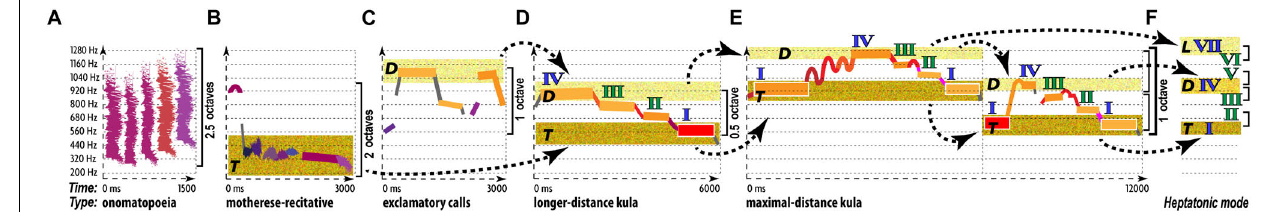
FIGURE 8 | Genesis of SFTO in the vocal tradition of kulning. The set of six panels shows five excerpts representing five different vocalization types from Figure 7 . They are placed on the same frequency grid to demonstrate how the registral position of phrasal tones evolves into a frequency range used to define a degree in a musical mode. Thin dashed vertical line indicates the phrasal ends. Thick curved dashed arrows show the genesis of “tonic” (principal stable) and “dominant” (principal unstable) degrees, eventually shaping a heptatonic mode. (A) Mid-distance onomatopoeia (barking) . This is the closest to ACs. A phrase repeats the same wideband aperiodic signal whose most intense part of the spectrum spreads over ≈ 2.5 octaves. (B) Close distance motherese/recitative . Low-register tones in such phrases tend to fall within the same narrow range of 250–290 Hz (257 c), marked by the darker grainy filling. Frequently repeated voiced vowels effectively refine the tuning of the “recitative tone” that adopts a tonic function (“T”) established by the common terminations of phrases. (C) Mid-distance exclamatory calls . High-register “shrieking” tones in such phrases are squeezed in a twice narrower range, marked by a lighter filling. These shrieking tones complement low tones in (B) in providing reference for pitch changes. Such tones prototype the “dominant” melodic function (“D”). Tones that fall in this register become imperfect “anchors” subdued to “tonic”—requiring a descending melodic “resolution” after them. (D) Longer-distance kula . Registral ranges of both “tonic” and “dominant” are further compressed into “degrees” of a simple 4-degree musical mode. Colored Roman numerals use blue for anchored tones, and green—for supporting tones (passing or auxiliary). Tonic function (stability) is shaped by the lowest degree terminating a phrase, whereas dominant function (instability)—by the highest degree initiating a phrase. This transformation is fueled by frequent stitching of (B) , (C) , and (D) phrases within the same musicking session as the distance changes. (E) Longest-distance kula . This type doubles the TO structure of the shorter distance kula—indicated by two thin vertical brackets encapsulated by one thick bracket. A similar tetrachordal structure is reproduced above the base-tetrachord. Both tetrachords are conjoined: the lowest stable degree (“T”) of an upper tetrachord becomes the highest unstable degree (“D”) of the lower tetrachord as kula descends from its opening phrase toward lower phrases, terminated by the lowest permanent “tonic.” Repeated use of such complex structure (common at distances over 1 km) is likely to turn it into a modal framework for the entire kulning, encompassing all its phrasal types. (F) Heptatonic mode in complex kulas . Frequent modulations between the conjoined tetrachords integrate both tetrachords into a single complex 2-tetrachordal mode with three axial degrees: the lowest I —a permanent tonic (“T”), the middle IV —an alternative temporary anchor that requires resolution (“D”), and the highest VII —a permanent unstable anchor, used to initiate sentences and/or build a climax—i.e., the “leading tone” (“L”) that always leads to more stable anchors (perfect and/or imperfect). These axial degrees enclose supplementary degrees, each of which is bound to the closest anchor, forming